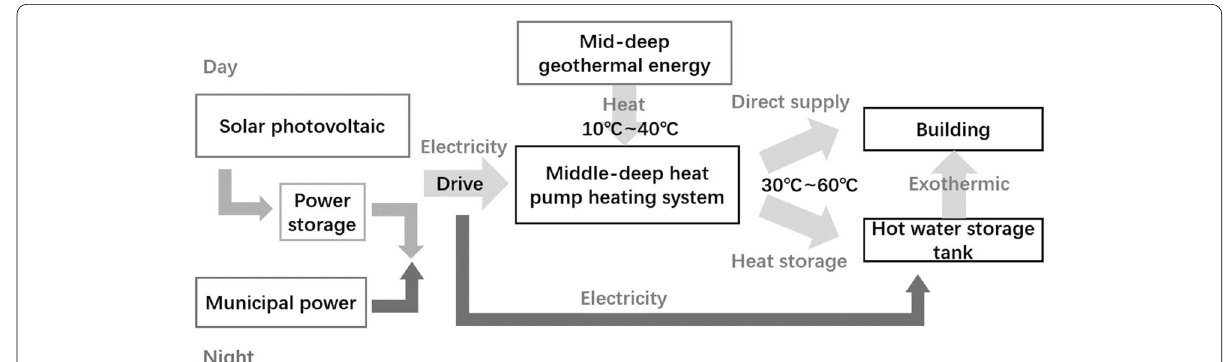
Fig. 13 Field area is based on geothermal energy to realize the design of a multi-grade energy coupling application scheme